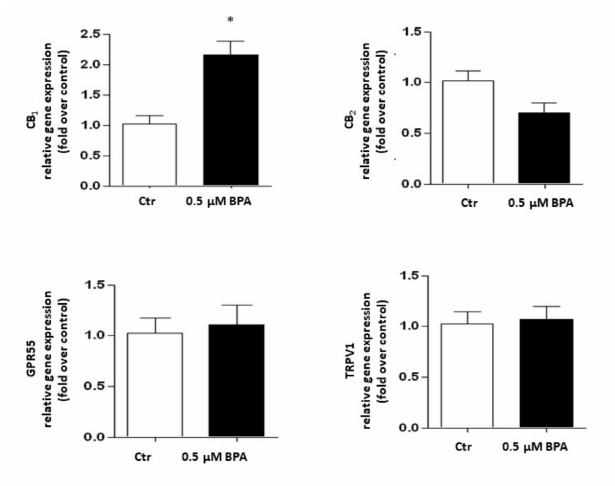
Figure 2. E ff ect of BPA (0.5 µ M for 48 h) on mRNA levels of eCB-binding receptors (CB 1 , CB 2 , GPR55 and TRPV1) in exposed Sertoli cells, compared to vehicle-treated controls (Ctr). Gene expression is reported as 2 − ∆∆ Ct values calculated by ∆∆ Ct method vs. Ctr, posed equal to 1.0. Expression levels of each gene were normalized to β -actin, and data were expressed as means ± SEM of 5 independent experiments. * p < 0.01 vs. Ctr.